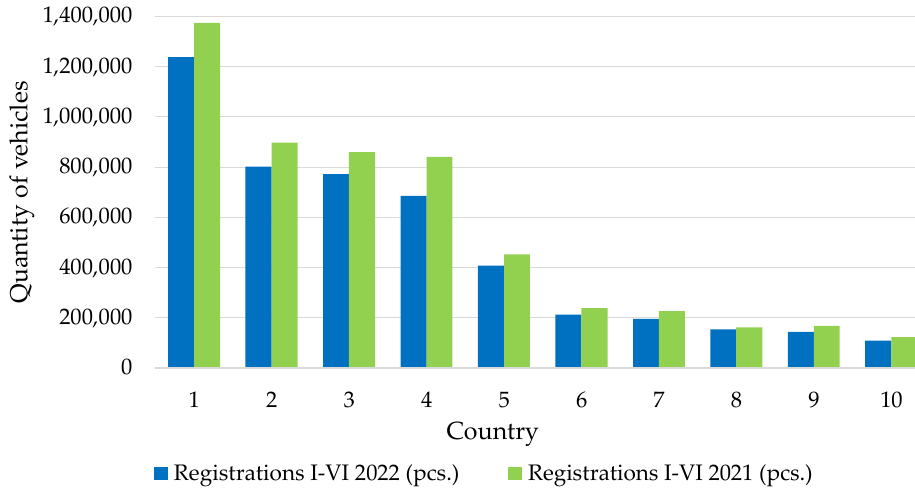
Figure 6. Sales of vehicles in Europe in the first half of 2022: 1 — Germany; 2 — Great Britain; 3 — France; 4 — Italy; 5 — Spain; 6 — Poland; 7 — Belgium; 8 — Netherlands; 9 — Sweden; 10 — Switzerland.